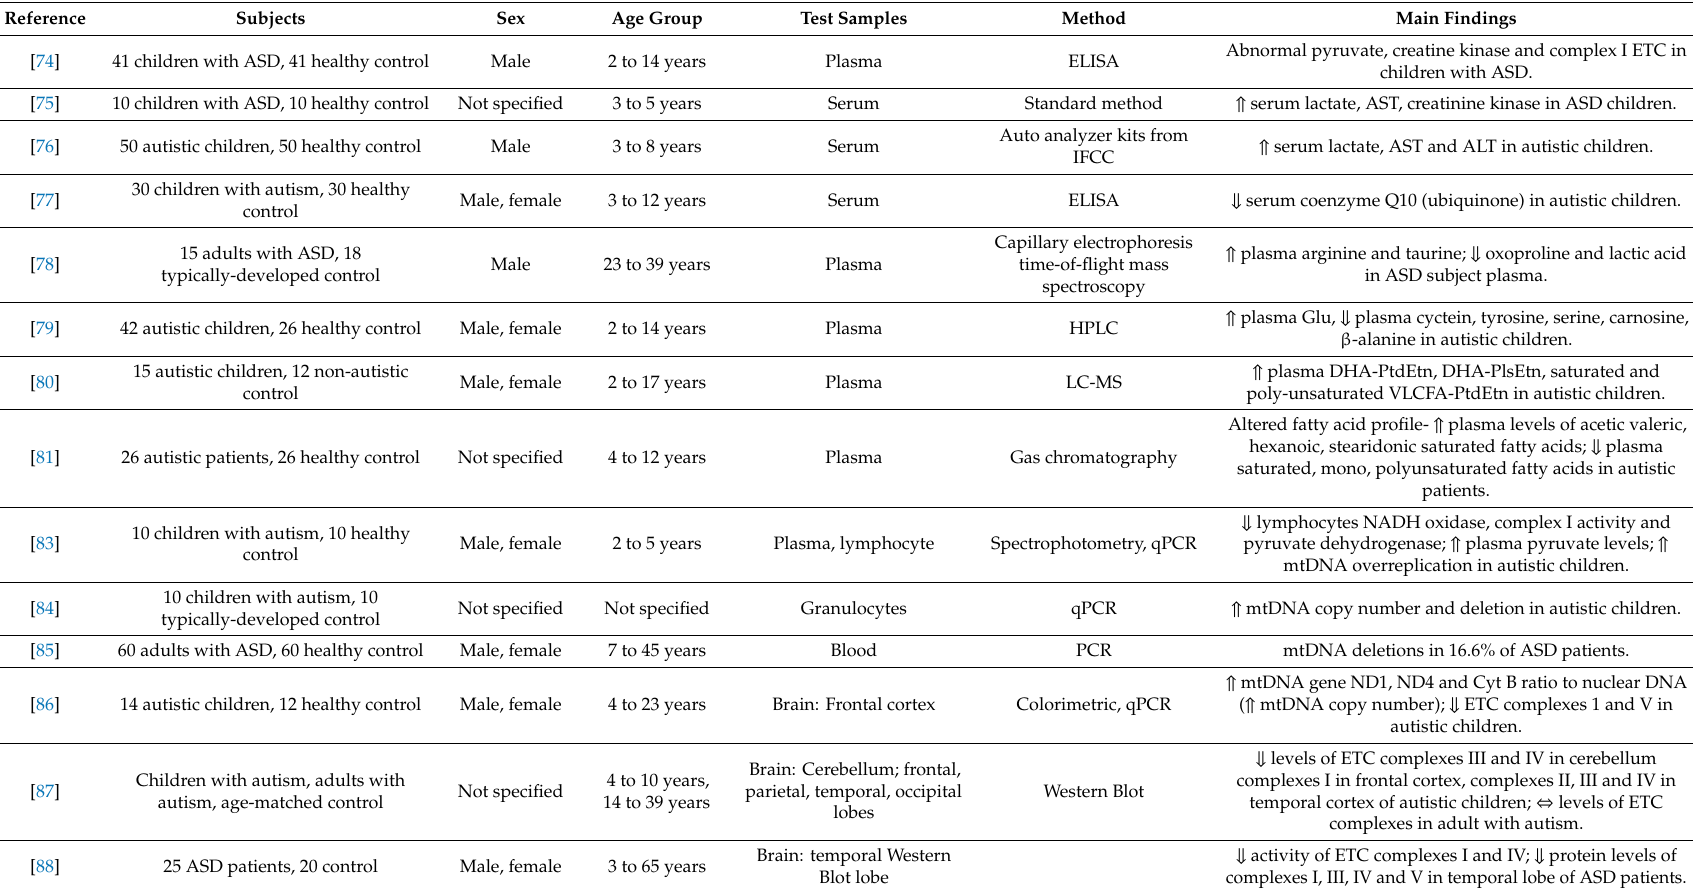
Table 4. Summary for previous evidences on mitochondrial dysfunction in